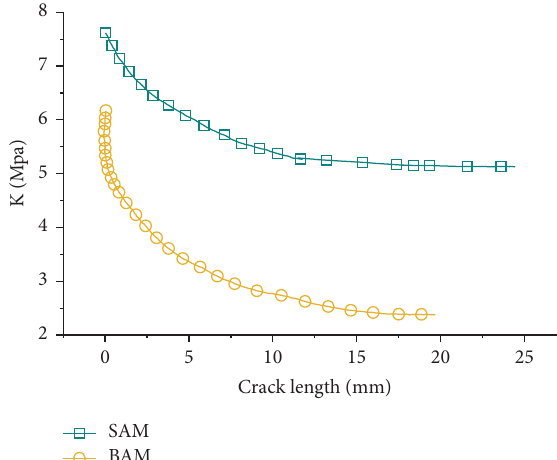
Figure 12: Stress states of two asphalt mixtures at diferent crack propagation depths of SAM and